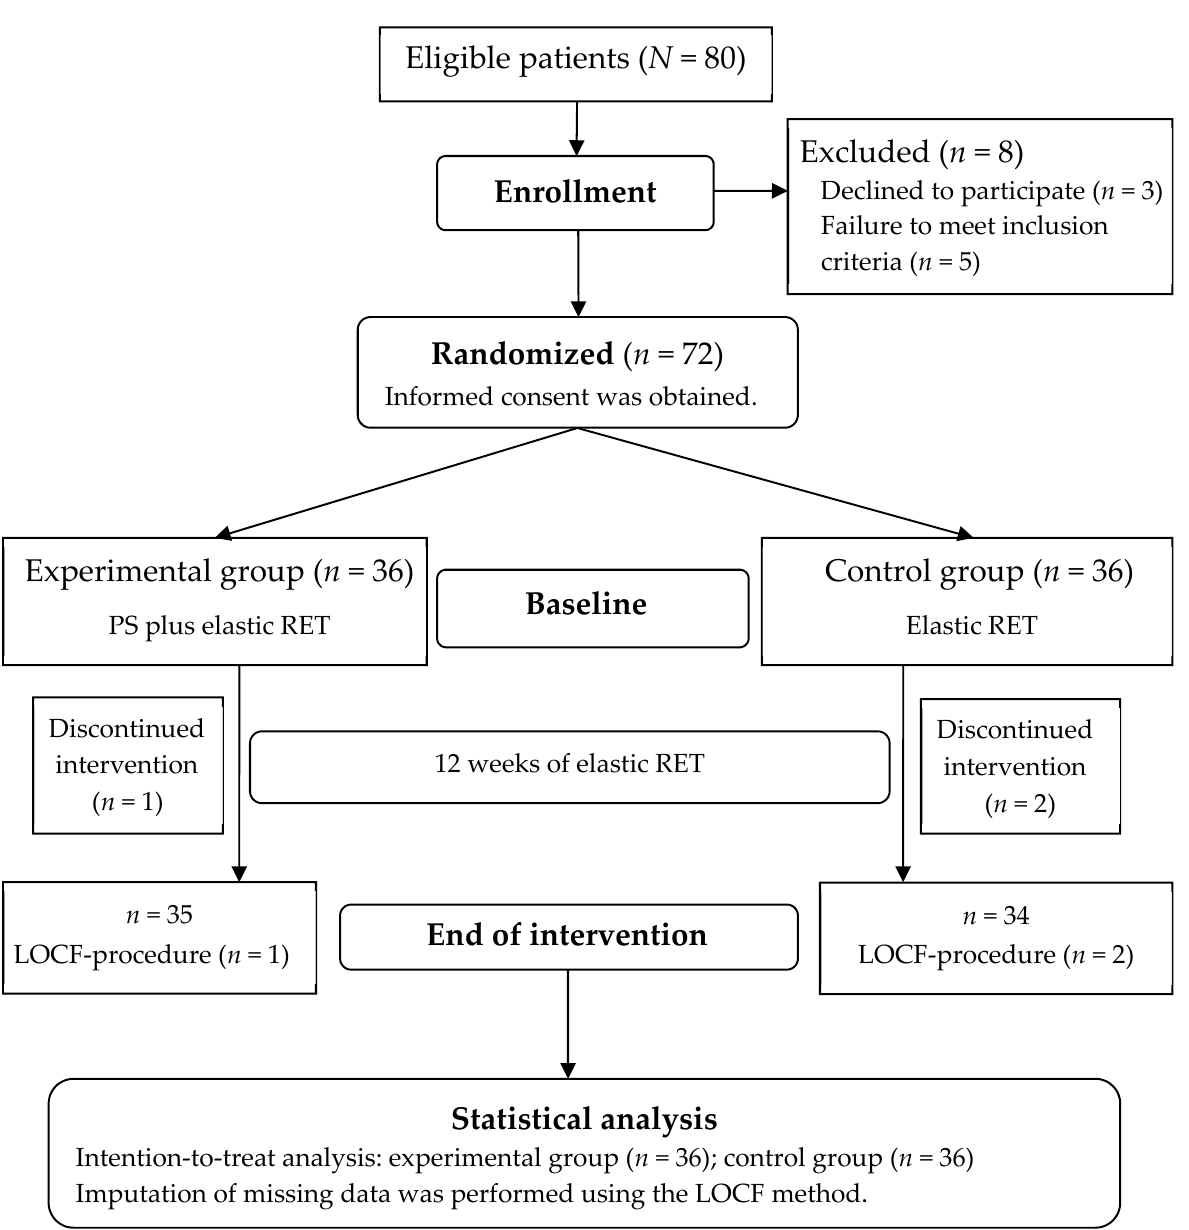
Figure 1. Study flowchart. LOCF, last observation carried forward; PS, protein supplement; RET, resistance exercise train- ing.